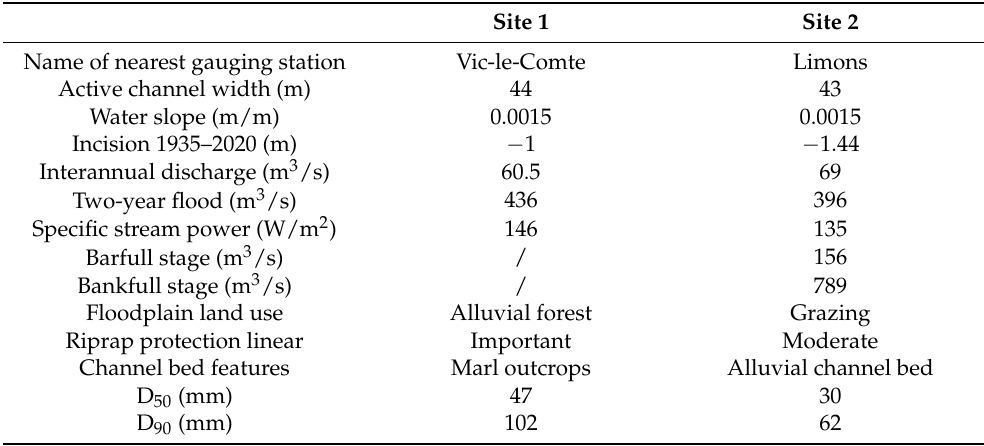
Table 2. Information and main geomorphological and hydrological characteristics of the two study sites.